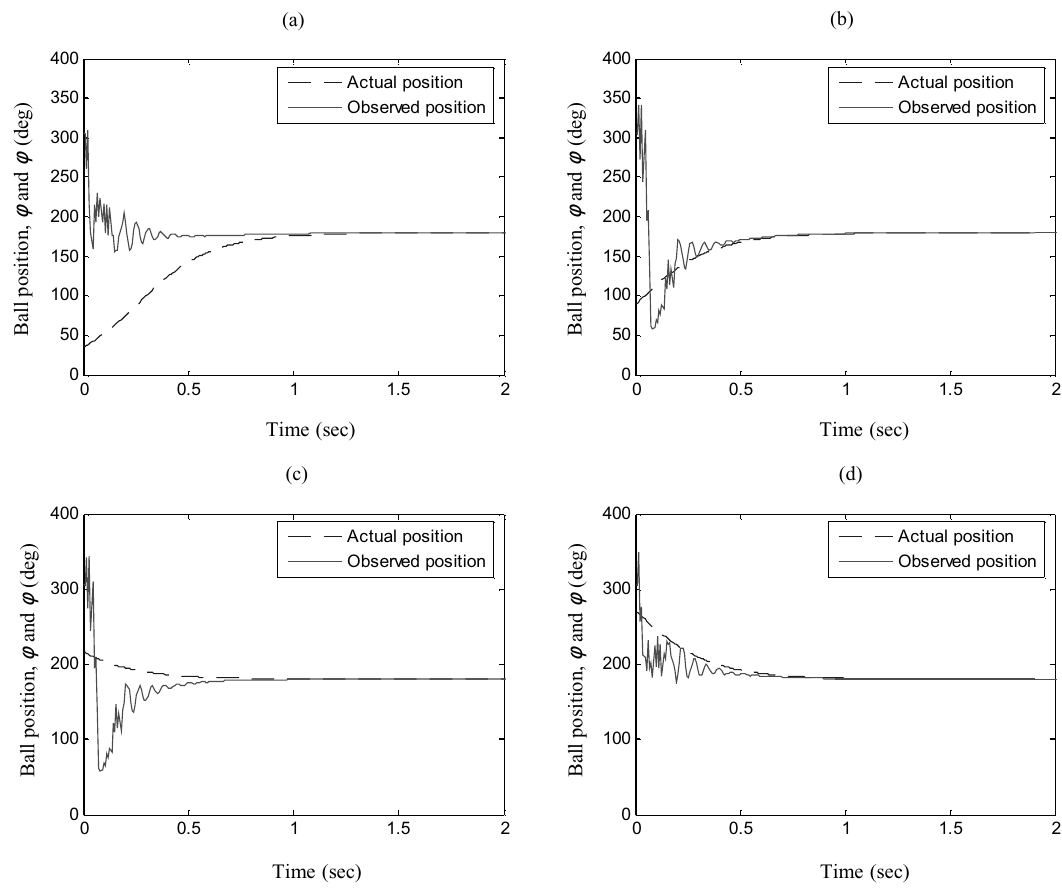
Fig. 12. Observed ball position based on the designed sliding-mode ball observer with l x = 460, k x = 4, a 1 = 1, a 2 = 40 and initial ball position at (a) 36 ◦ , (b) 90 ◦ , (c) 216 ◦ and (d) 270 ◦ . imbalance of the spindle-disc-ABS system. As stated in Section 3.2, the regulator is designed to drop the spindle speed to the neighborhood of system’s first translational resonance frequency, 1300 rpm, for several trials until the observed steady-state ball position is at 180 degree. Figures 15–17 show experimental results of the